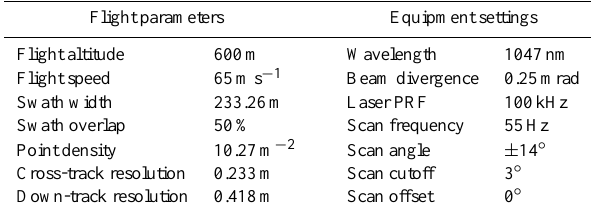
Table 2. Flight parameters and sensor